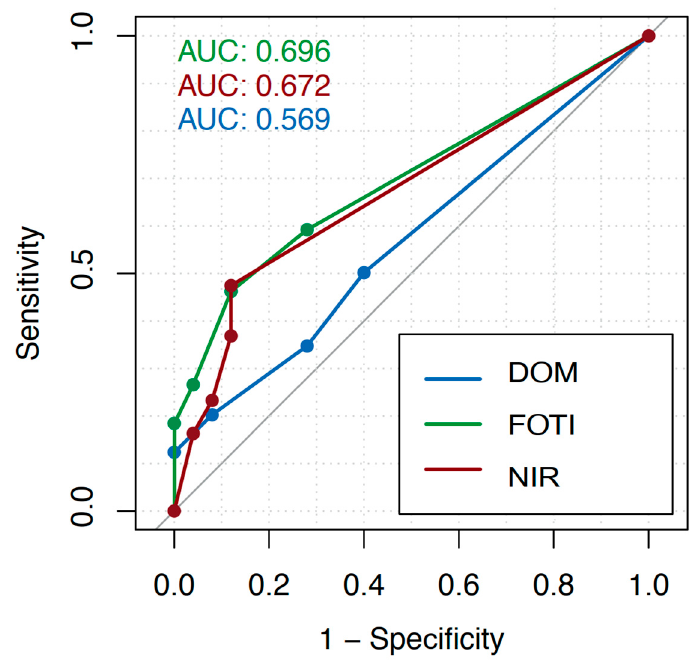
Figure 2. Receiver operating characteristic (ROC) curves considering all tooth surfaces for each applied investigation method (dental operating microscope, DOM; fiber-optic transillumination, FOTI; near-infrared transillumination, FOTI) and different cutoff values of the crack depth scores. The diagnostic value of each method was calculated as the area under the curve (AUC).